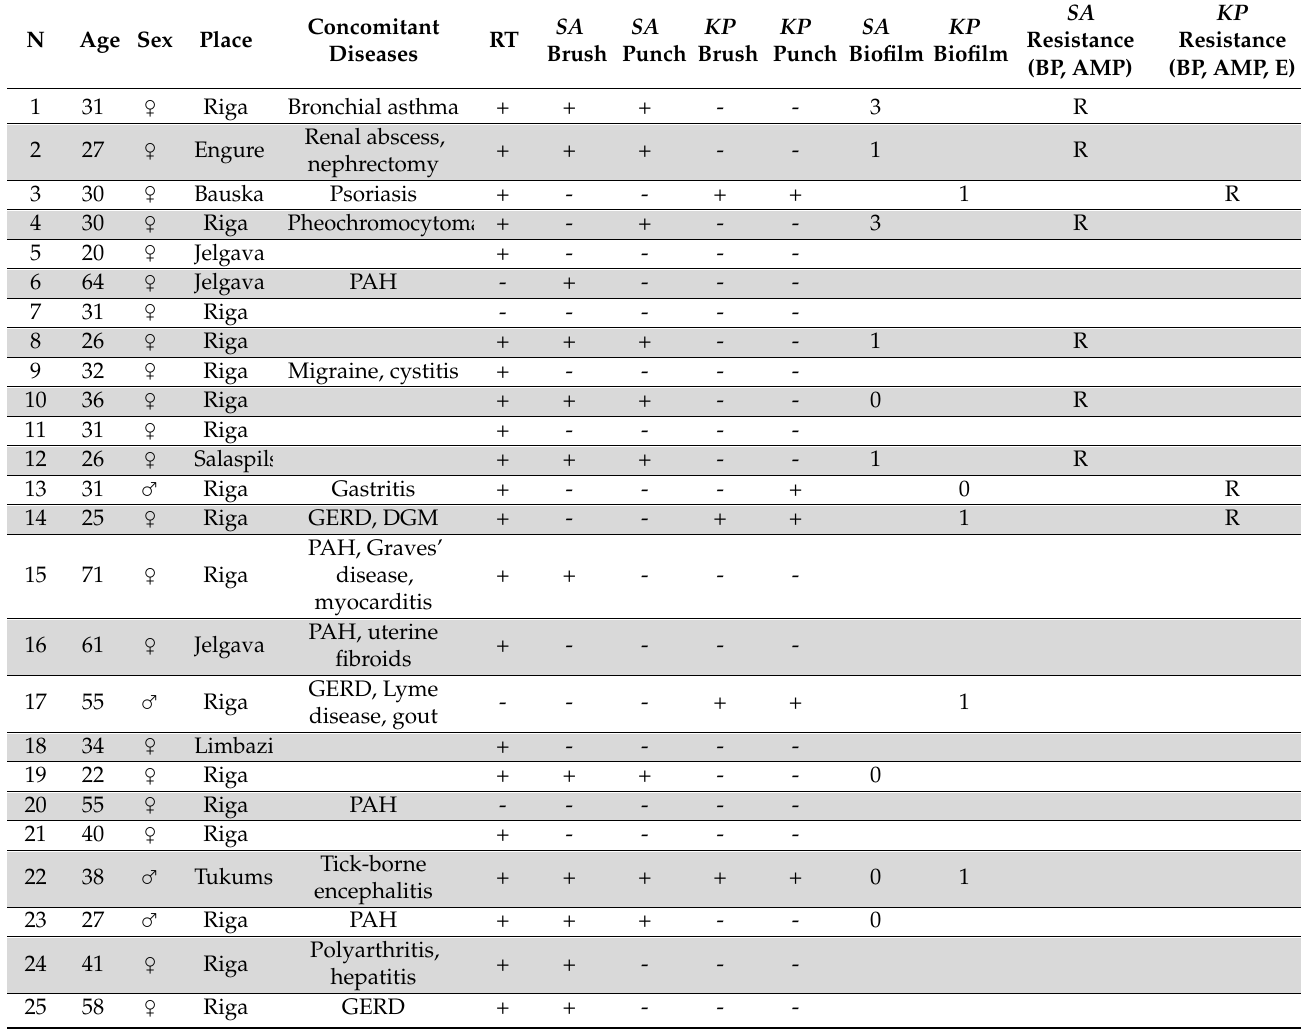
Table 3. Characteristics of the study population. Note: PAH, primary arterial hypertension; GERD, gastroesophageal reflux disease; DGM, dysregulation of glucose metabolism; RT, recurrent episodes of tonsillitis during the past 3 years; SA, S. aureus ; KP, K. pneumoniae ; 0, biofilm nonproducer; 1, weak producer; 2, moderate producer; 3, strong producer; R, resistance; BP, benzylpenicillin; AMP, ampicillin; E,